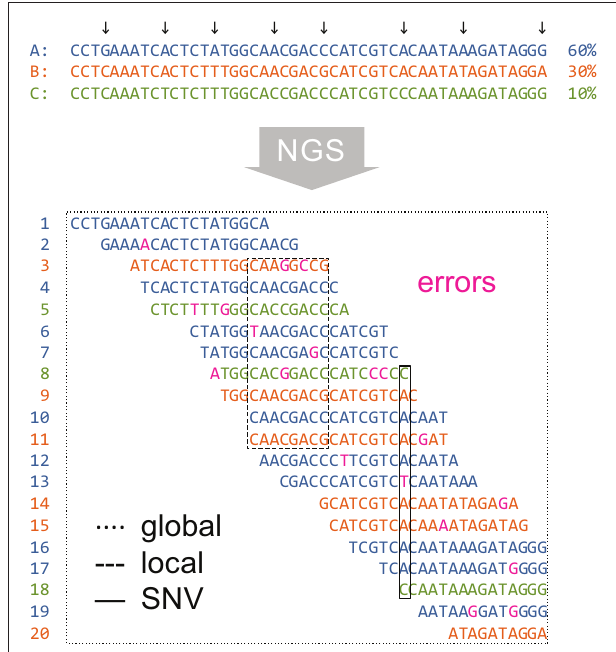
FIGURE 2 | Spatial scales of diversity estimation from NGS data. In this example, it is assumed that the true virus population (top of figure) consists of three haplotypes of relative frequencies 60% (A, blue), 30% (B, orange), and 10% (C, green). Segregating sites are indicated by arrows. Twenty short reads (labeled 1 through 20) are generated by NGS from the virus population subject to sequencing errors (indicated in magenta). Reads are displayed in a MSA and in the color of their corresponding parental haplotype. Diversity estimation can be approached at single sites (SNV detection, solid-line rectangle), in windows of the MSA (local haplotype inference, dashed-line rectangle), or over the entire genomic region (global haplotype reconstruction, dotted-line rectangle).